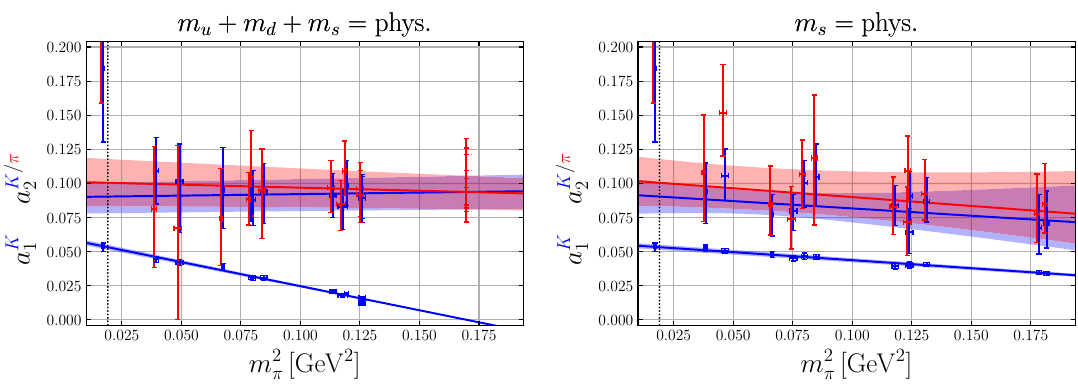
Figure 10 . Summary plot for the first and second Gegenbauer moments of the pion (red) and the kaon (blue) in the continuum limit along two quark mass trajectories: fixed average quark mass (left) and fixed strange quark mass (right). These two trajectories intersect at the physical point (dotted vertical line). The error bands shown are statistical